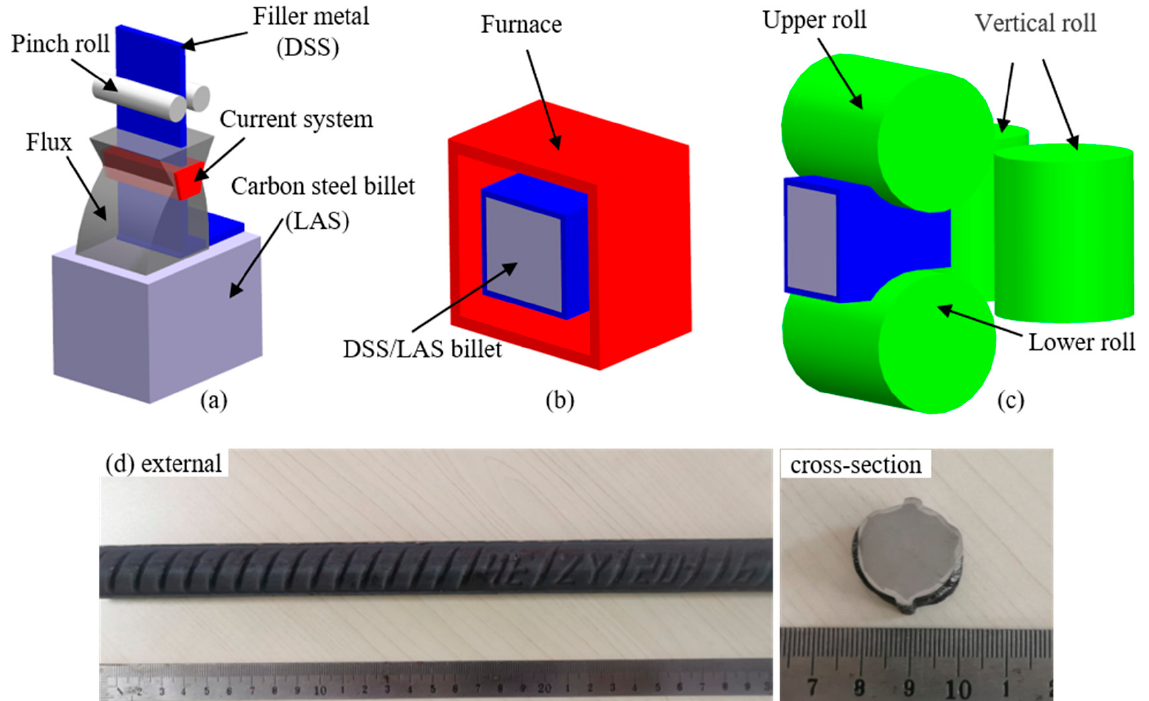
Figure 1. Simplified diagrams of the DSS/LAS-clad rebar production process. ( a ) The manufacturing of the DSS/LAS billet, which used metal deposition, ( b ) the DSS/LAS billet soaking in a furnace, ( c ) hot rolling, ( d ) macro-scale external and cross-sectional views.